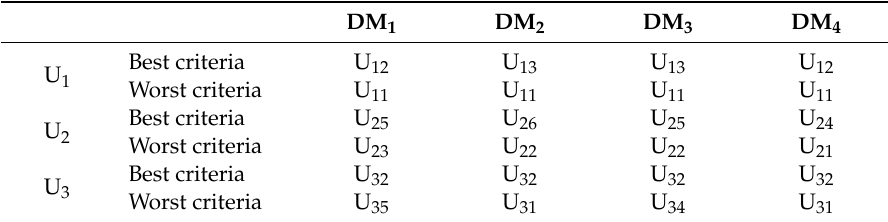
Table 7. The best and worst criteria of sub-criteria.